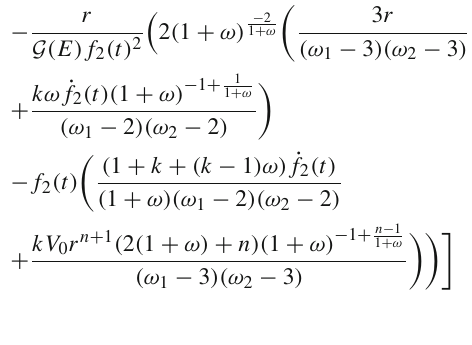
Fig. 7 a – d Show the variation of the thermalization temperature T , Total energy U , Helmholtz free energy F 1 and specific heat in constant volume C against r respectively for different values of equation of state